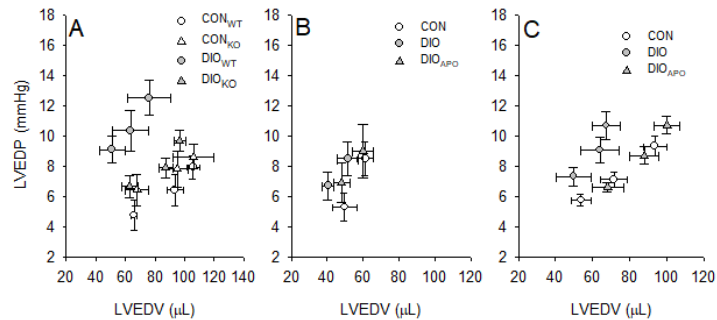
Figure 2. Steady state left ventricular end-diastolic volumes (LVEDV) and pressures (LVEDP) at three different workloads (preload: 4,6 and 8 mmHg and afterload: 50mmHg) from lean controls (CON WT and CON KO ) and obese (DIO WT and DIO KO ) wild type and NOX2 KO mice fed a high fat diet for 28 weeks ( A ), as well as lean (CON), obese (DIO) and apocynin-treated obese (DIO APO ) C57BL/6J mice fed a western diet for 18 ( B ) and 28 weeks ( C ). n = 5–10 per group, the values are mean ± SEM.